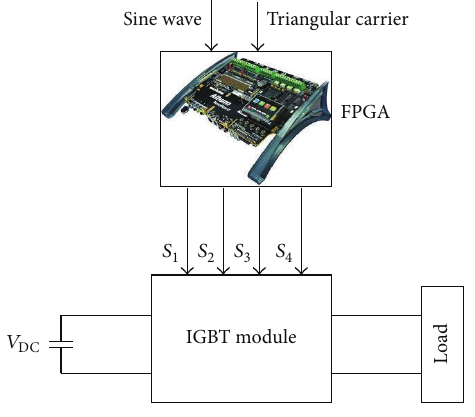
Figure 23: Schematic diagram for hardware setup.